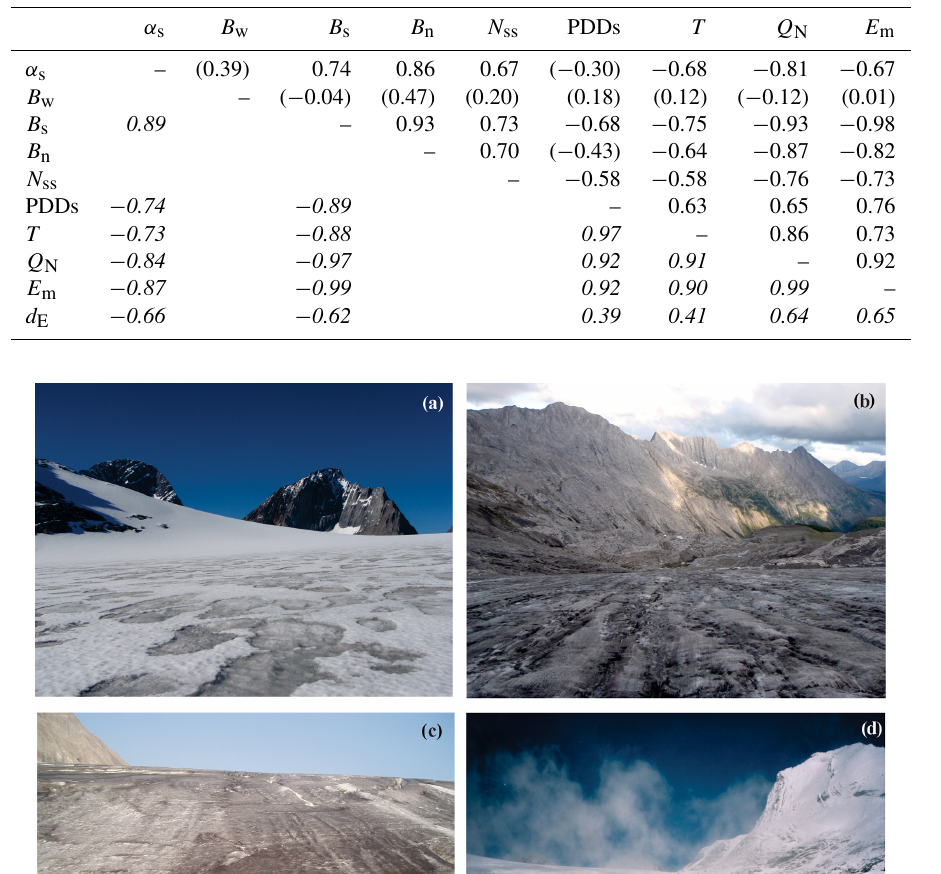
Table 3. Linear correlation coefficients for albedo, energy balance, and mass balance conditions at Haig Glacier, 2002–2015. Symbols are defined in Tables 1 and 2. The top right sector is for mean summer (JJA) and annual mass balance conditions ( N = 14), and the bottom left sector (italicized) shows correlation coefficients for all available monthly mean values from May to September ( N = 71). For the monthly data, B s refers to the monthly summer balance (melting minus refreezing), defined as a negative for mass loss. B n and B w are not relevant for the monthly data. Correlations that are not significant at the 95% level ( p > 0 . 05) are shown in brackets.